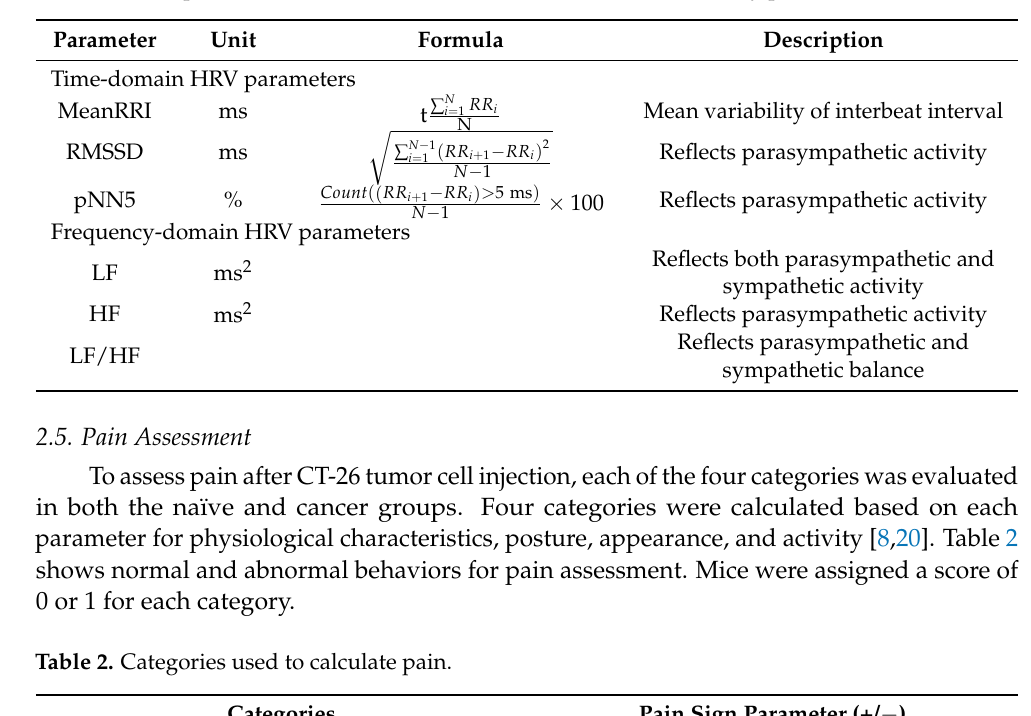
Table 1. Descriptions and formulas used to calculate heart rate variability parameters.